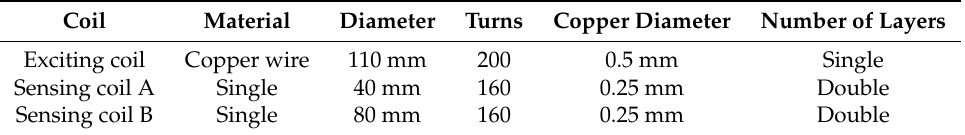
Table 3. Specific parameters of the three coils.